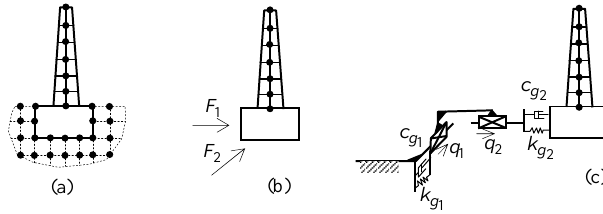
Figure 1. North-South displacement component of El Centro earthquake, California, 1940.